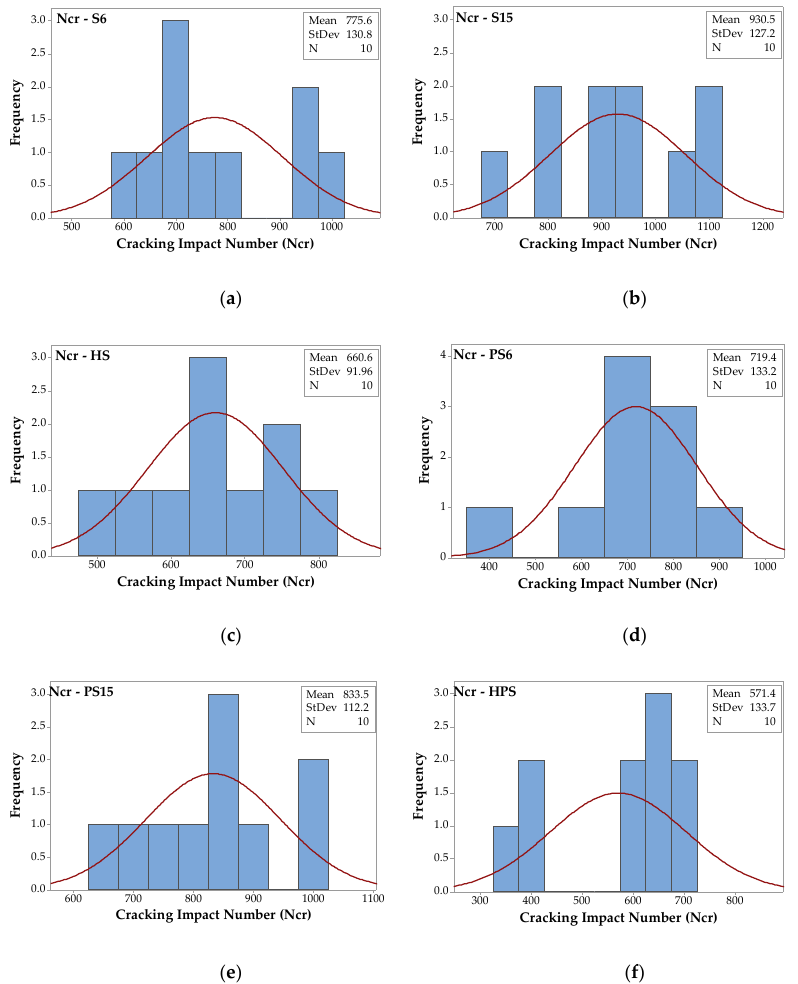
Figure 9. Normal distribution histograms of the cracking impact number Ncr. ( a ) S6; ( b ) S15; ( c ) HS; ( d ) PS6; ( e ) PS15; ( f ) HPS.